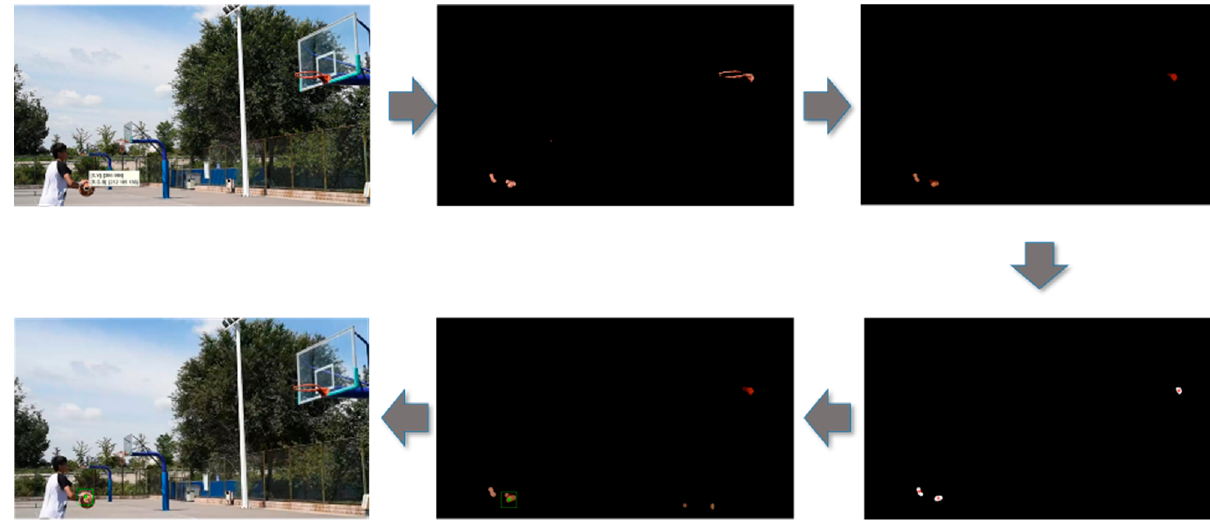
Figure 4. RGB component acquisition process of basketball position.